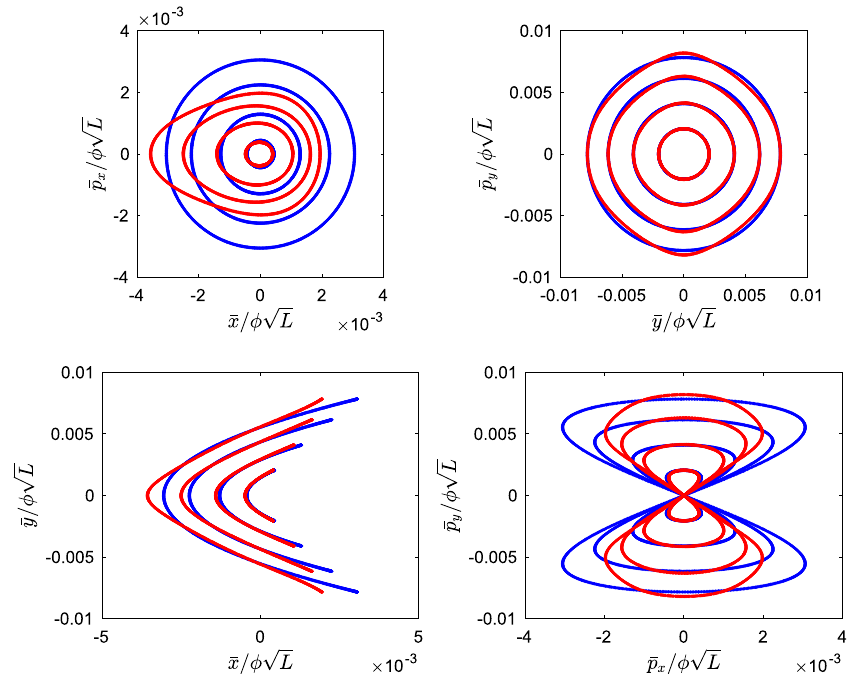
− 2 ν 0 . 618 and with ν x y x ¼